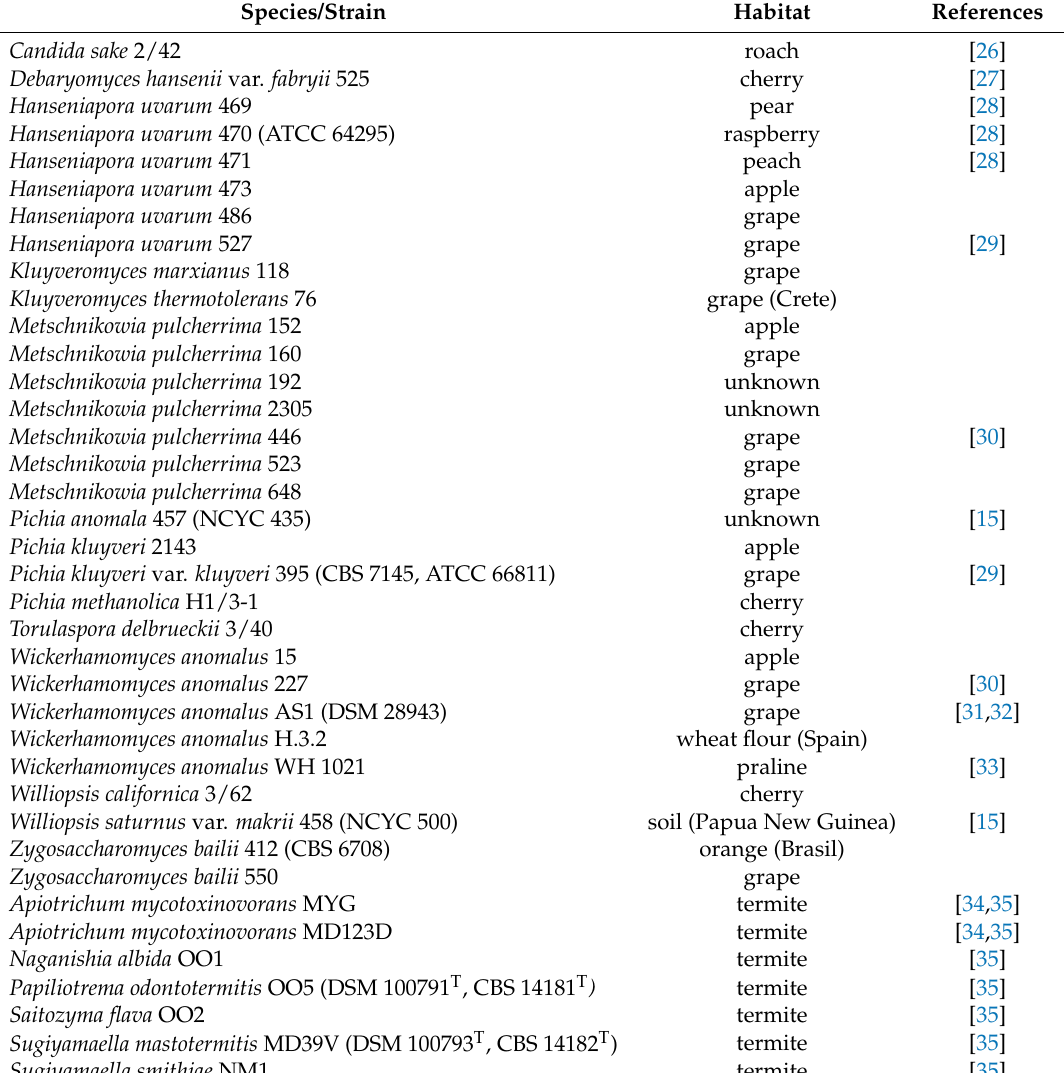
Table 1. Yeast strains investigated as putative antagonistic